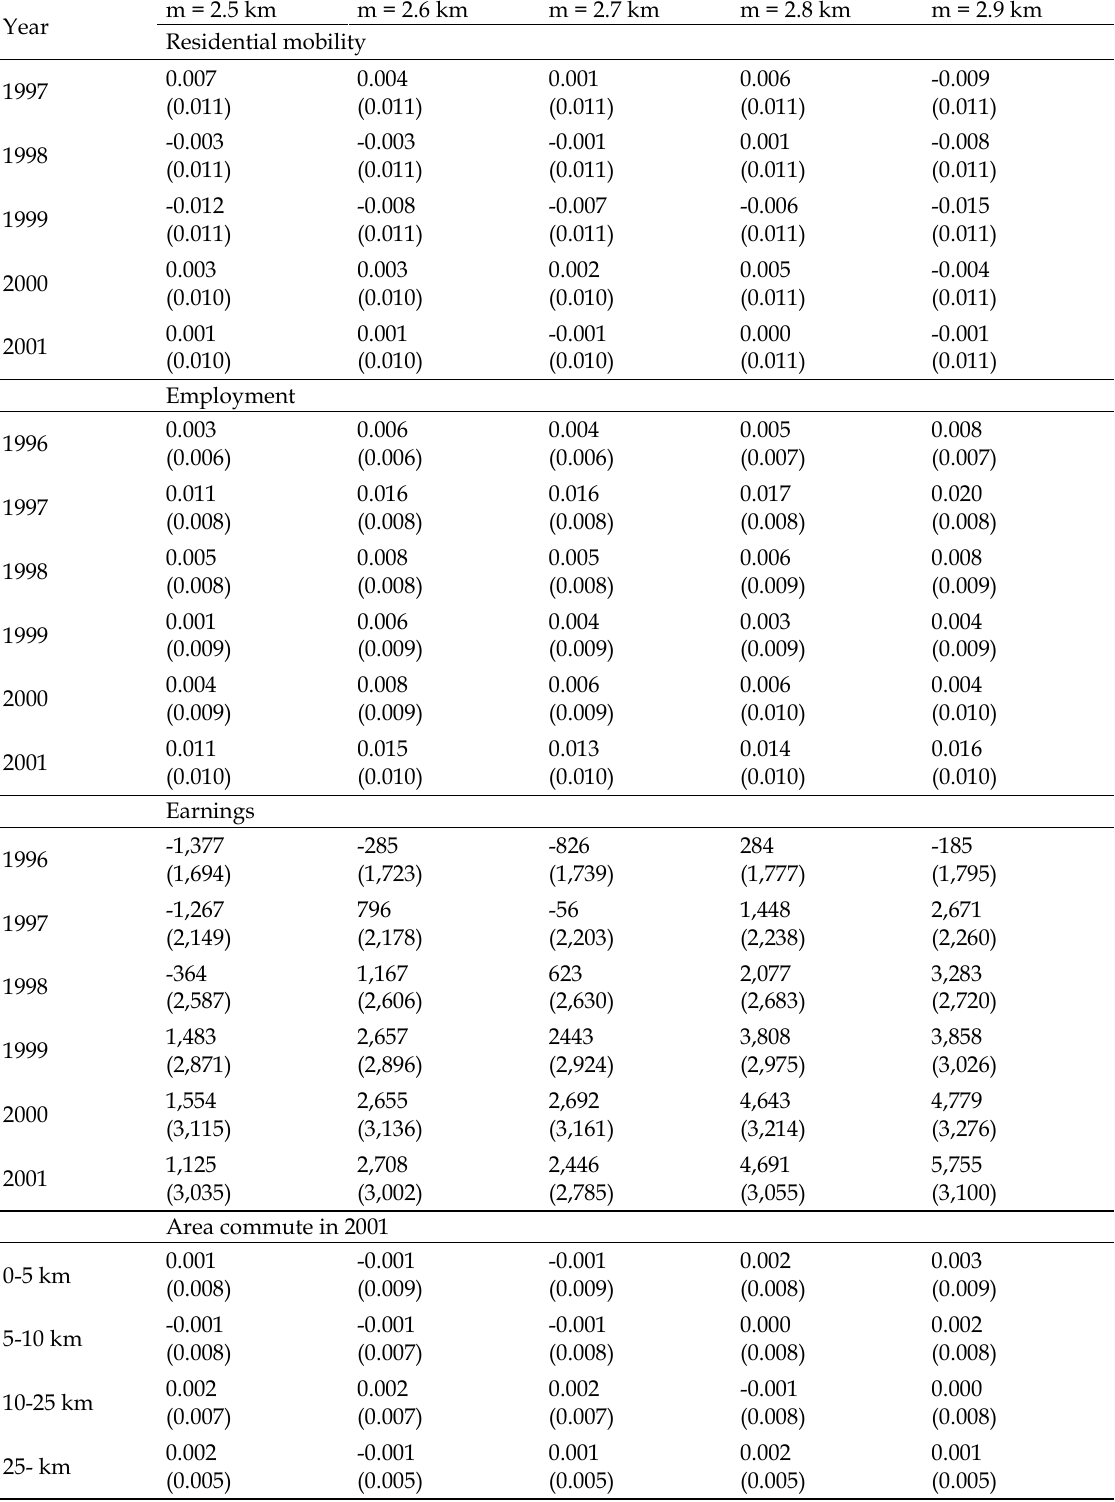
Table 2. Estimated pre-treatment effects of improved job